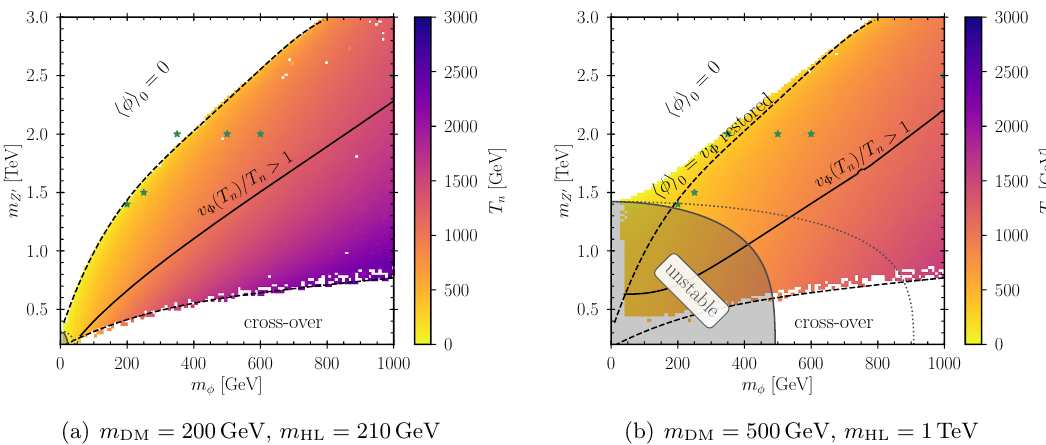
Figure 17 . Parameter points giving rise to a cosmological (cid:12)rst-order phase transition with a nucleation temperature T n , including the contribution from dark matter and the exotic leptons. The dashed lines indicate the corresponding region neglecting the fermion contributions (cf. (cid:12)gure 16(b)). In the gray shaded region, the potential becomes unstable below (cid:30) = 100 GeV; above the gray, dotted line it is stable up to (cid:30) = 10 6 TeV. The stars indicate benchmark points listed in appendix C. absence of fermions. If the dark sector leptons are included, their contributions have the opposite sign and partially cancel the bosonic ones, and the global minimum at (cid:30) = v (cid:8) is restored. Hence, the region allowing for a (cid:12)rst-order PT is extended. On the other hand, if the fermionic corrections overcome the bosonic ones at high (cid:12)eld values, the potential is destabilized as it is not bounded from below. This occurs for low Z 0 and (cid:30) masses. The gray shaded regions are excluded since the potential becomes unstable at (cid:12)eld values below (cid:30) = 100 TeV, i.e. V e(cid:11) (100 TeV) < V e(cid:11) ( (cid:30) ) at T = 0. Above the gray, dotted curve h i 0